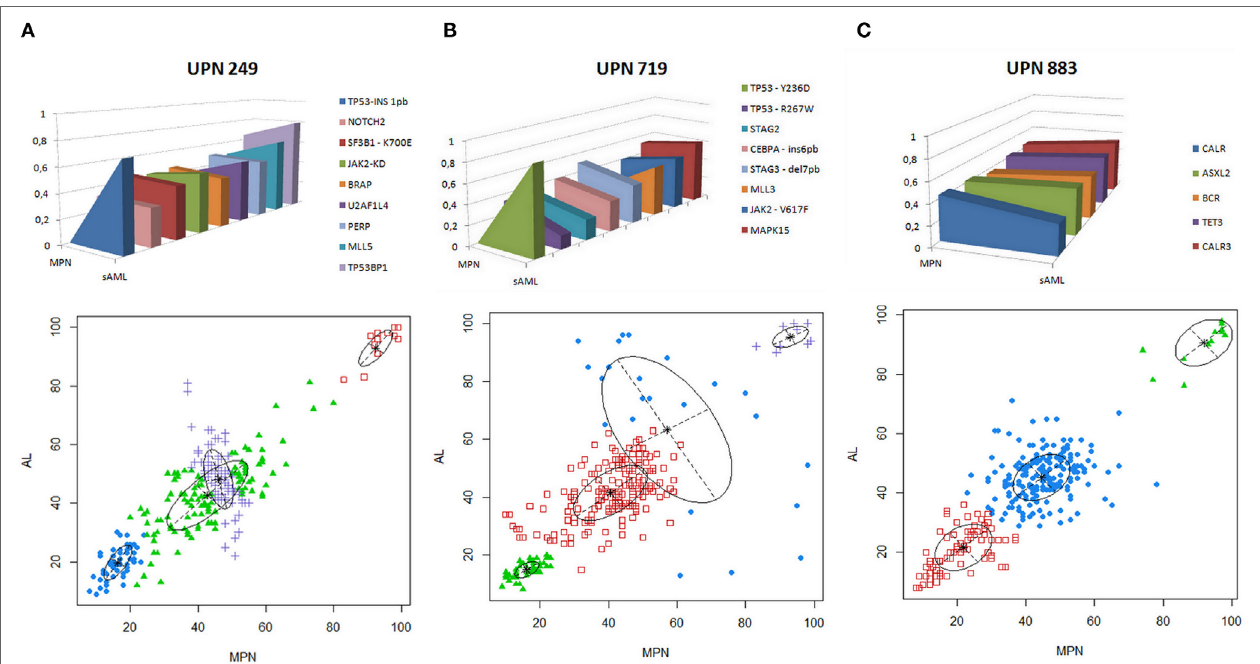
FigUre 3 | (a–c) Genomic landscape of thrombocythosis (ET and MPN/MDS) that progressed to sAML. VAF of candidate driver mutations or paralogous genes already associated with MPN phenotype in each patient analyzed are depicted in upper panels. Model of clonal evolution of MPN to sAML showing average VAF of each subclone in the stages analyzed. Clonal evolution complexity showing VAF of mutations found in each clone per patient in MPN (abcissa) and sAML (ordinate) stages is depicted in the lower panels. VAF plots were generated by mclust after running fpc and nselectboot functions. ET, essential thrombocythemia; MDS, myelodysplastic syndrome; MPN, myeloproliferative neoplasm; sAML, secondary acute myeloid leukemia.; UPN, unique patient number; VAFs, variant allele